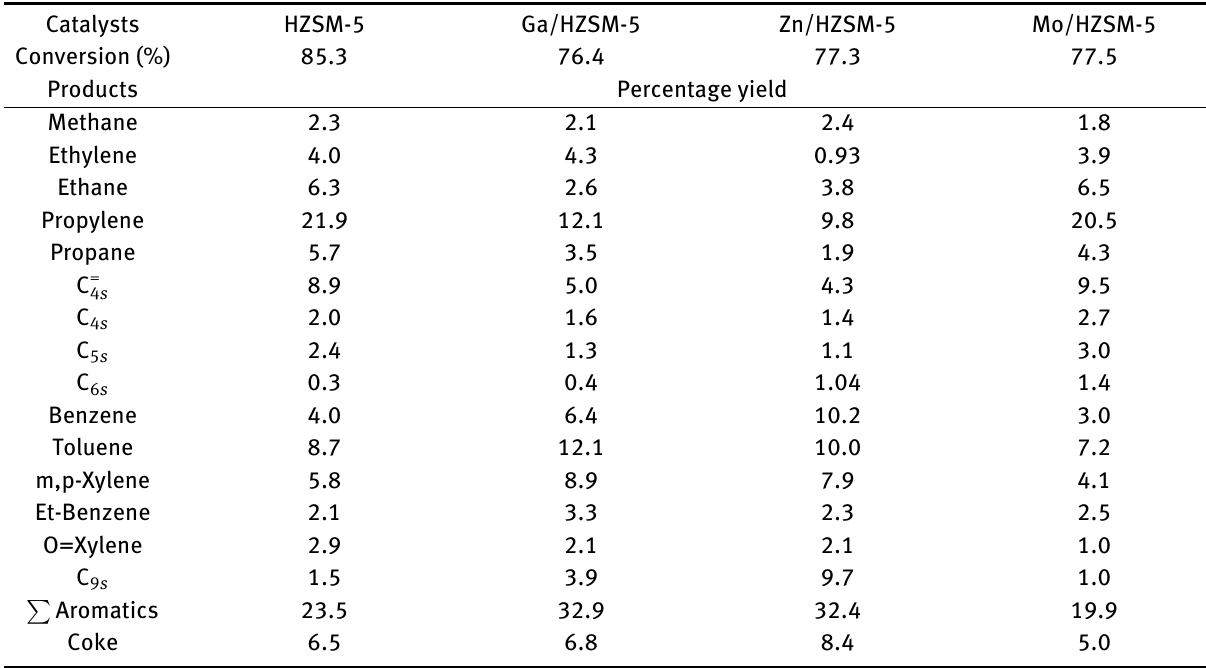
Table 11: Product distribution [61] Catalysts